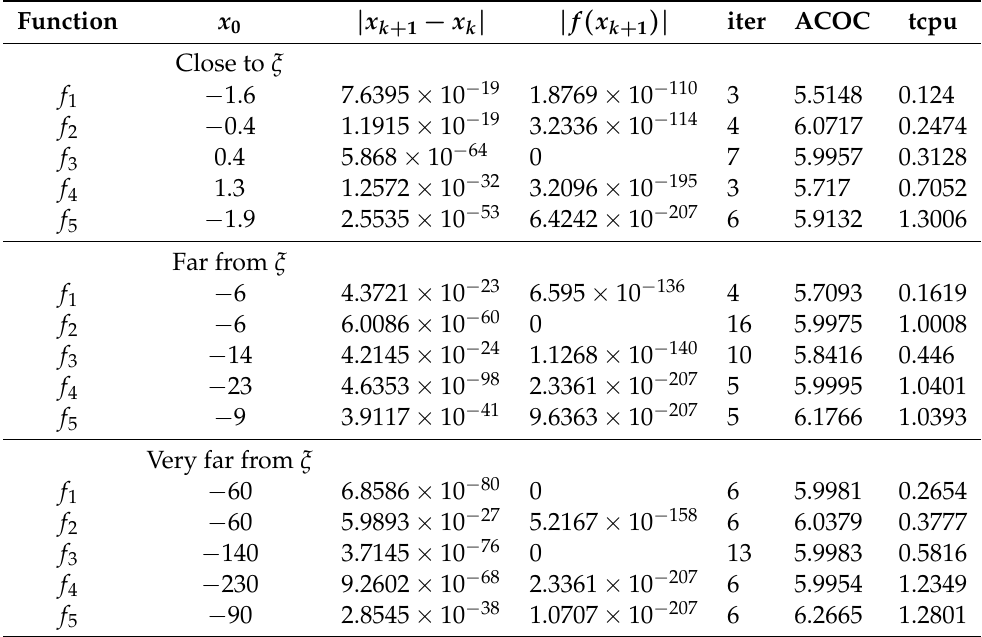
Table 6. Numerical performance of CMT (1) method in nonlinear equations.